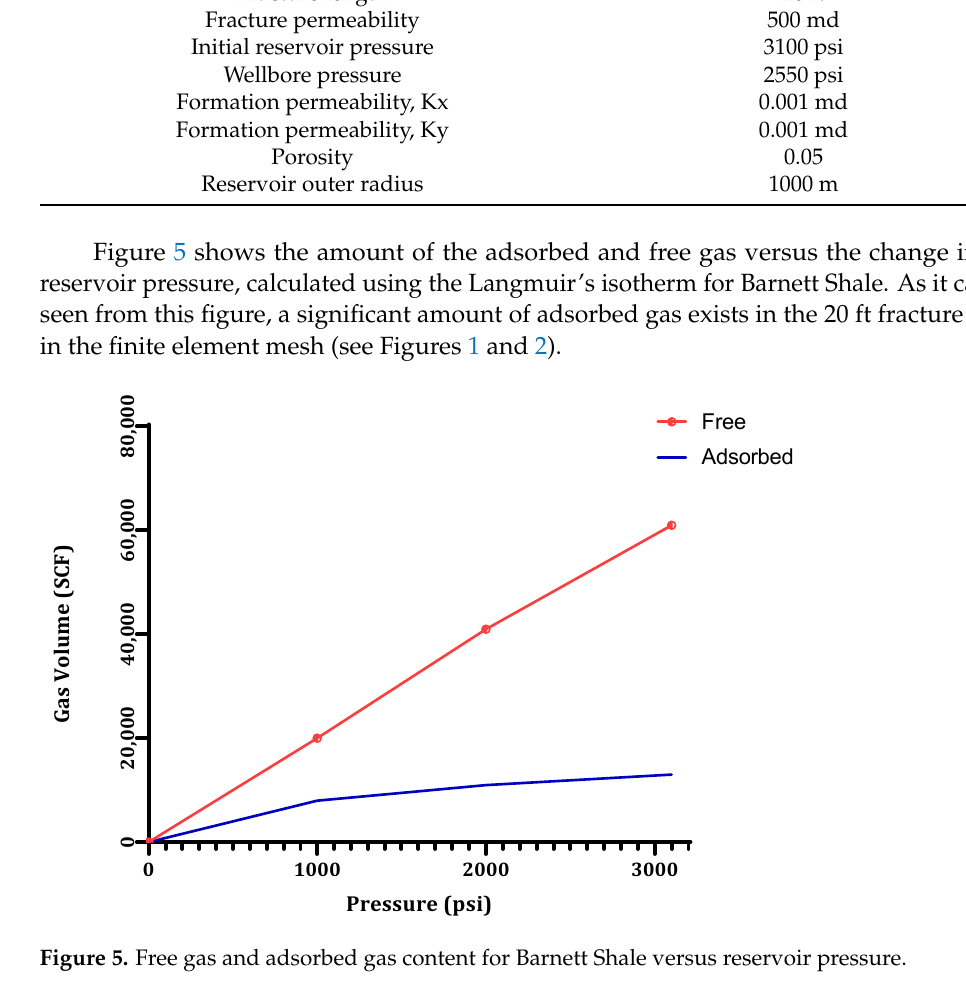
Figure 5. Free gas and adsorbed gas content for Barnett Shale versus reservoir pressure.